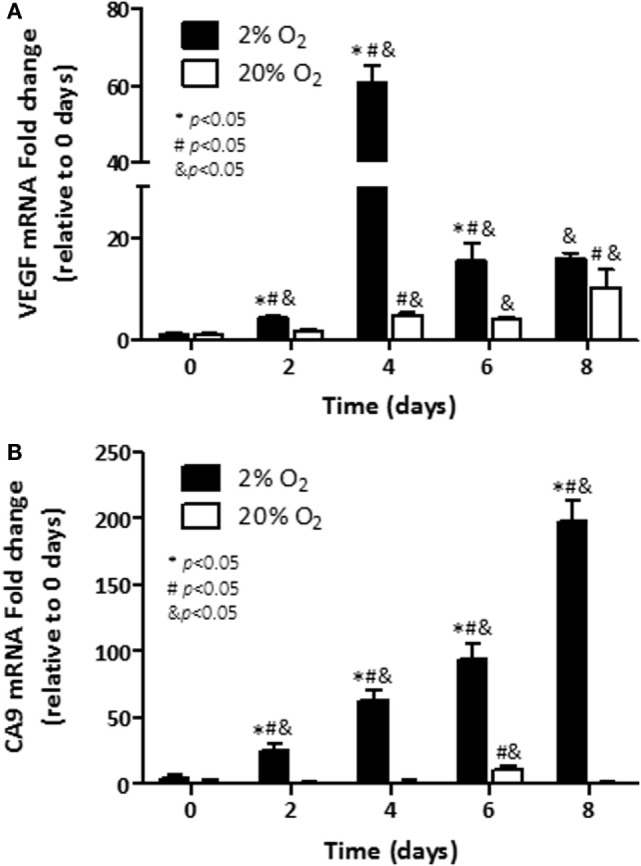
Assessment transcripts of hypoxia-responsive genes: mRNA levels of; (A) Vascular endothelial growth factor (VEGF) and; (B) carbonic anhydrase 9 (CA9) were analyzed in C4-2B cells growing under hypoxia (■) or normoxia (□). *p < 0.05 when data at 2% O2 are compared to values at 20% O2 at the same time point; #p < 0.05 when data at 2% O2 or 20% O2 are compared to a previous time point within the same O2%; and &p < 0.05 when a specific data point is compared to the point at day 0 within the same O2%.